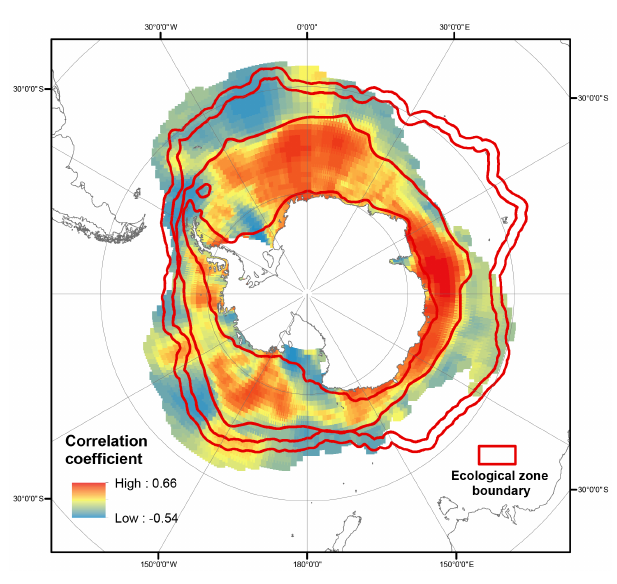
Figure 5. Temporal correlation between annual NPP and normal- ized iceberg